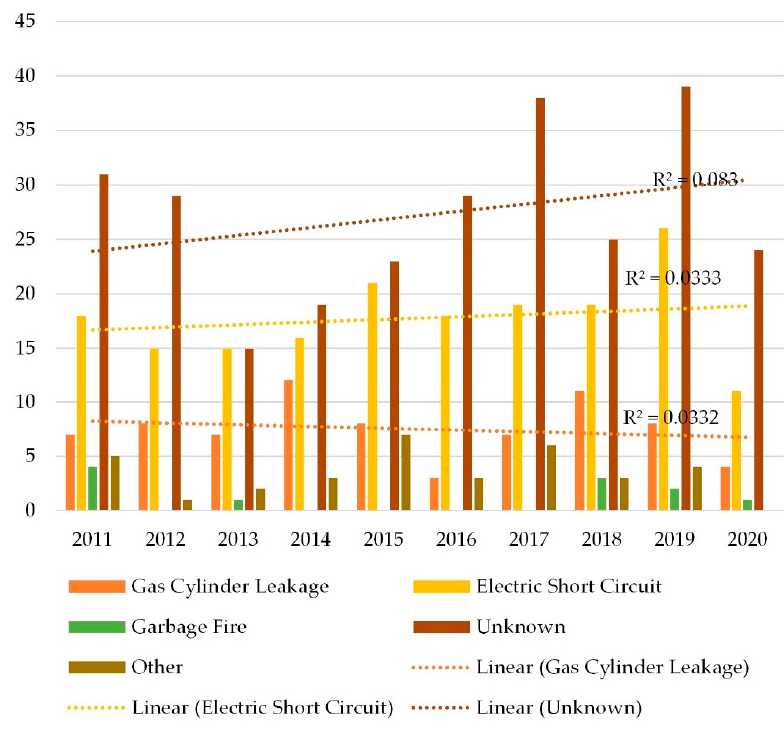
Figure 13. Cause-wise yearly structure